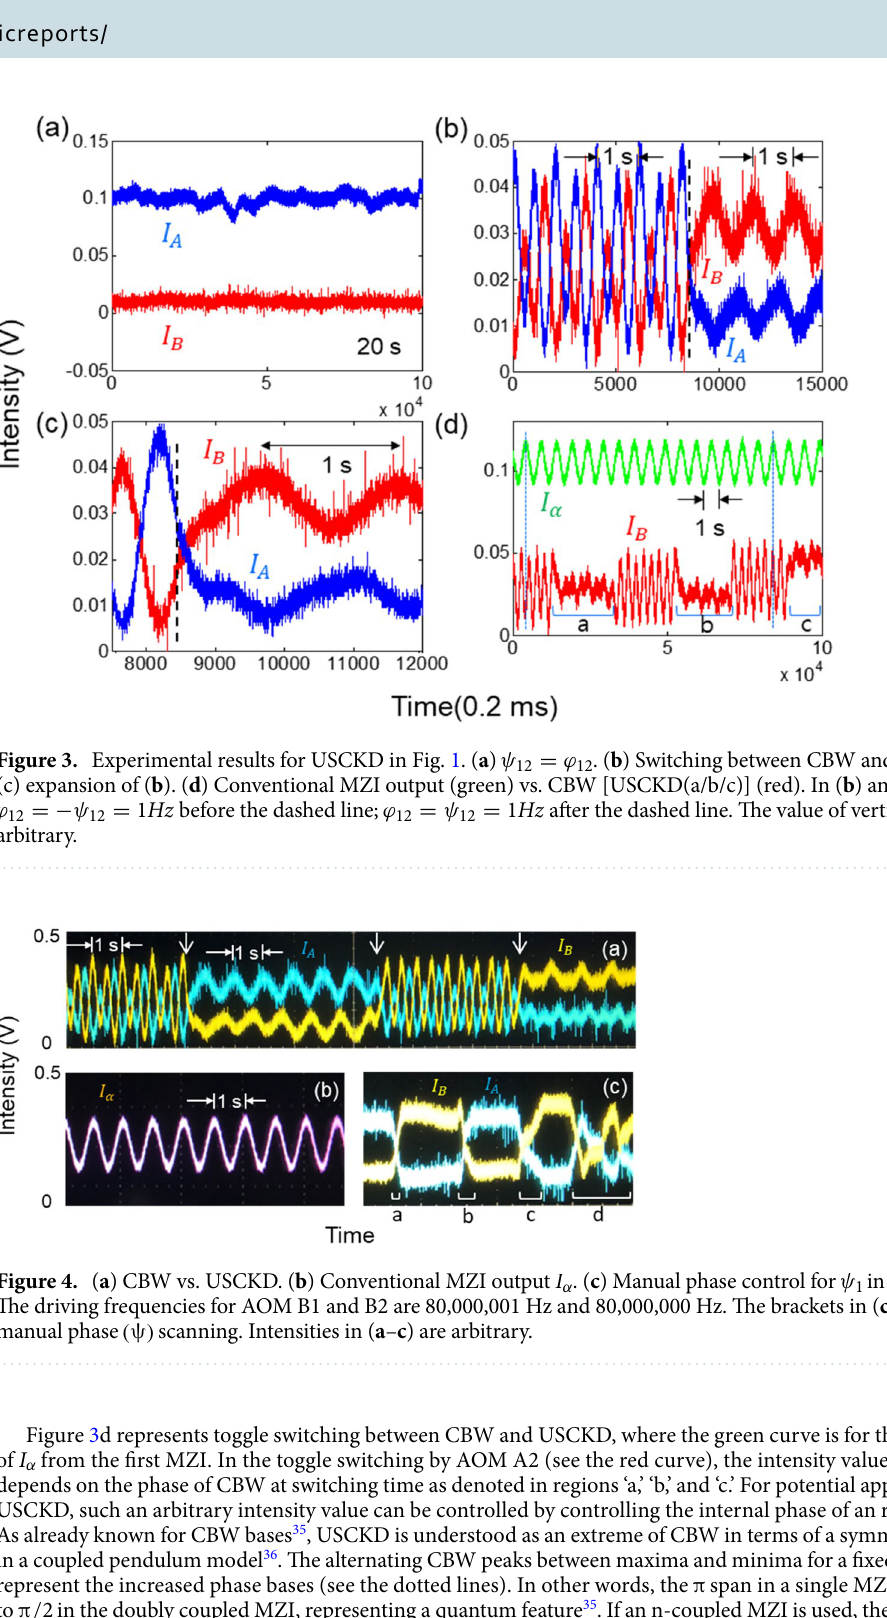
Figure 3d represents toggle switching between CBW and USCKD, where the green curve is for the reference of I α from the first MZI. In the toggle switching by AOM A2 (see the red curve), the intensity value of USCKD depends on the phase of CBW at switching time as denoted in regions ‘a,’ ‘b,’ and ‘c.’ For potential applications of USCKD, such an arbitrary intensity value can be controlled by controlling the internal phase of an rf generator. As already known for CBW bases 35 , USCKD is understood as an extreme of CBW in terms of a symmetric mode in a coupled pendulum model 36 . The alternating CBW peaks between maxima and minima for a fixed value of I α represent the increased phase bases (see the dotted lines). In other words, the π span in a single MZI is reduced to π / 2 in the doubly coupled MZI, representing a quantum feature 35 . If an n-coupled MZI is used, then the phase basis span is reduced to π / n 35 . The related movie is shown in section C of the Supplementary Information for toggle switching between CBW and USCKD. Figure 4 shows screen captures of the output intensities from the oscilloscope for Fig. 3. Figure 4a corresponds to Fig. 3b, where both the identity and inversion relations for USCKD in Fig. 2 are shown as results of toggle switching with AOM A2 from CBW. As shown, the maxima and minima of I A and I B are swapped according to a proper phase at the switching time as discussed in Fig. 3(d). Figure 4b is for the I α from the first MZI as a reference, whose modulation frequency (beating) is 1 Hz due to the preset 1 Hz driving frequency difference between AOMs B1 and B2. As mentioned in Fig. 2 as well as Eqs. (5)–(8), Fig. 4c shows ψ dependent intensity −